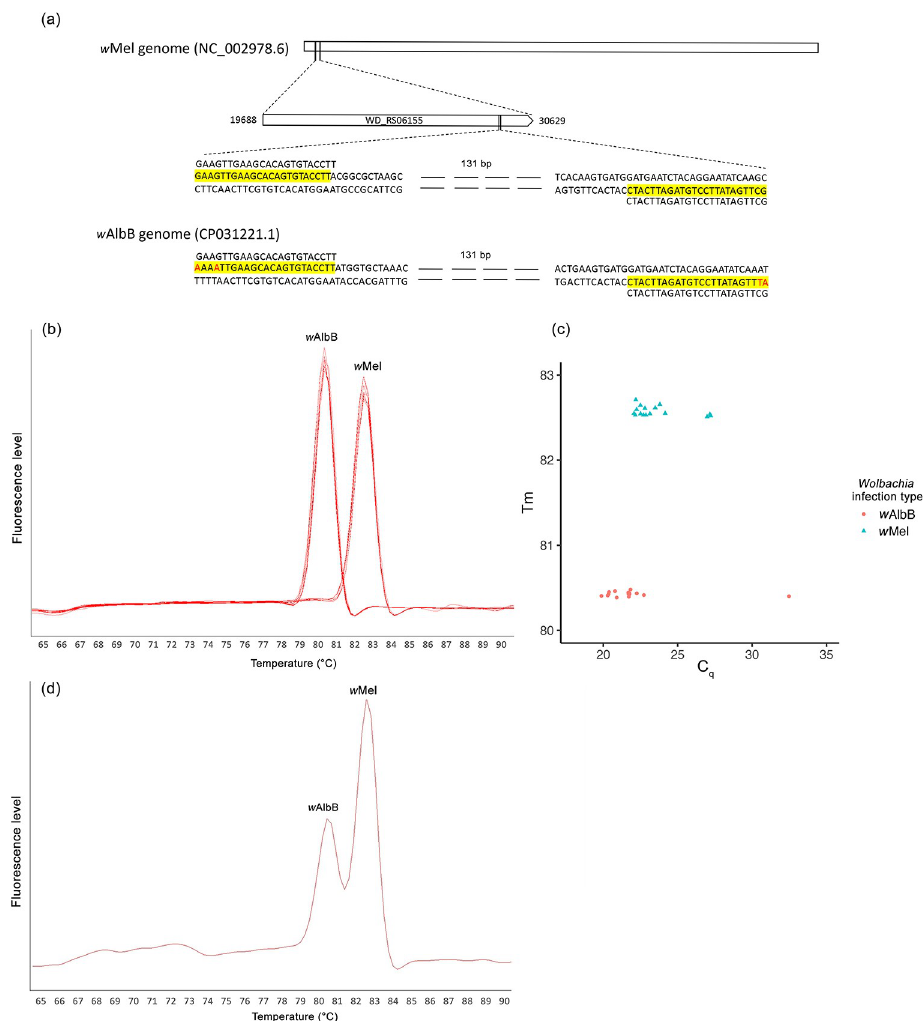
Fig 1. Development of primers to detect Wolbachia w Mel and w AlbB infection in Aedes aegypti . (a) The new primer pair wMwA aligns to a region in gene WD_RS06155 of w Mel, and also aligns to its analogue in the w AlbB genome which has two base-pair mismatches at the 3’- end; (b) the wMwA primers showed distinct Tm peaks for Wolbachia w Mel and w AlbB. (c) the wMwA primers showed distinct Tm values for Wolbachia w Mel (82.6 ± 0.03˚C) and w AlbB (80.4 ± 0.02˚C), the x axis represents the quantification cycle (C q ) and the y axis represents the amplicon melting temperature; (d) the wMwA primers showed two Tm peaks when mixing DNA templates of w Mel and w AlbB- infected Ae . aegypti .